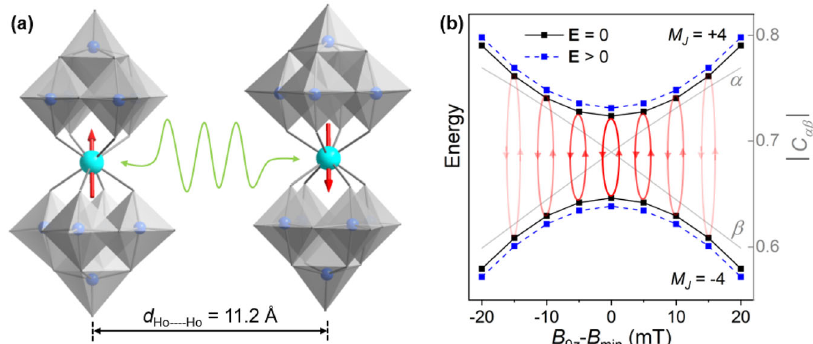
Fig. 1 A weakly dipolarly coupled HoW 10 -HoW 10 . a Nearest inversion-related HoW 10 pair within the crystal, illustrating their dipolar interaction. Their magnetic axes point in opposite directions. b Calculated energies (left axis) and mixing degree (right axis) of the eigenstates in terms of the M J ¼ ±4 j > spin states of HoW 10 as a function of magnetic and electric fi elds. α and β are the eigenstate coef fi cients (i.e., ¼ þ 4 Ψ ¼ α M J